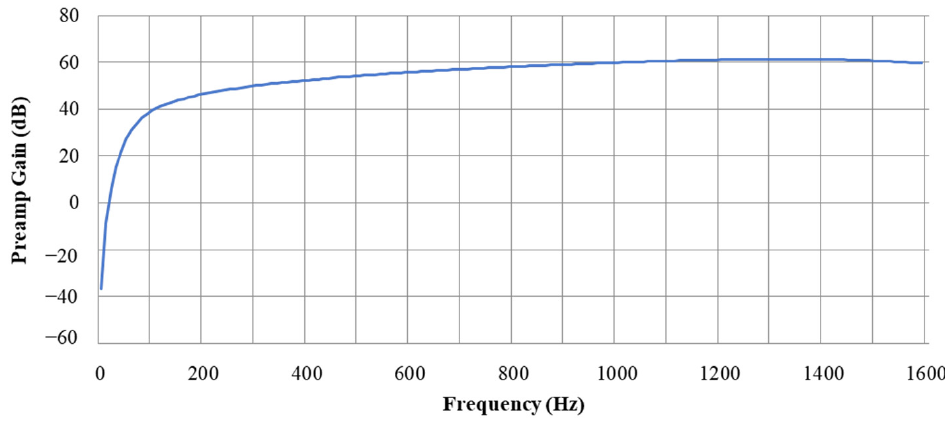
Figure 2. Preamp gain of an acoustic sensor reflecting underwater sound characteristics.